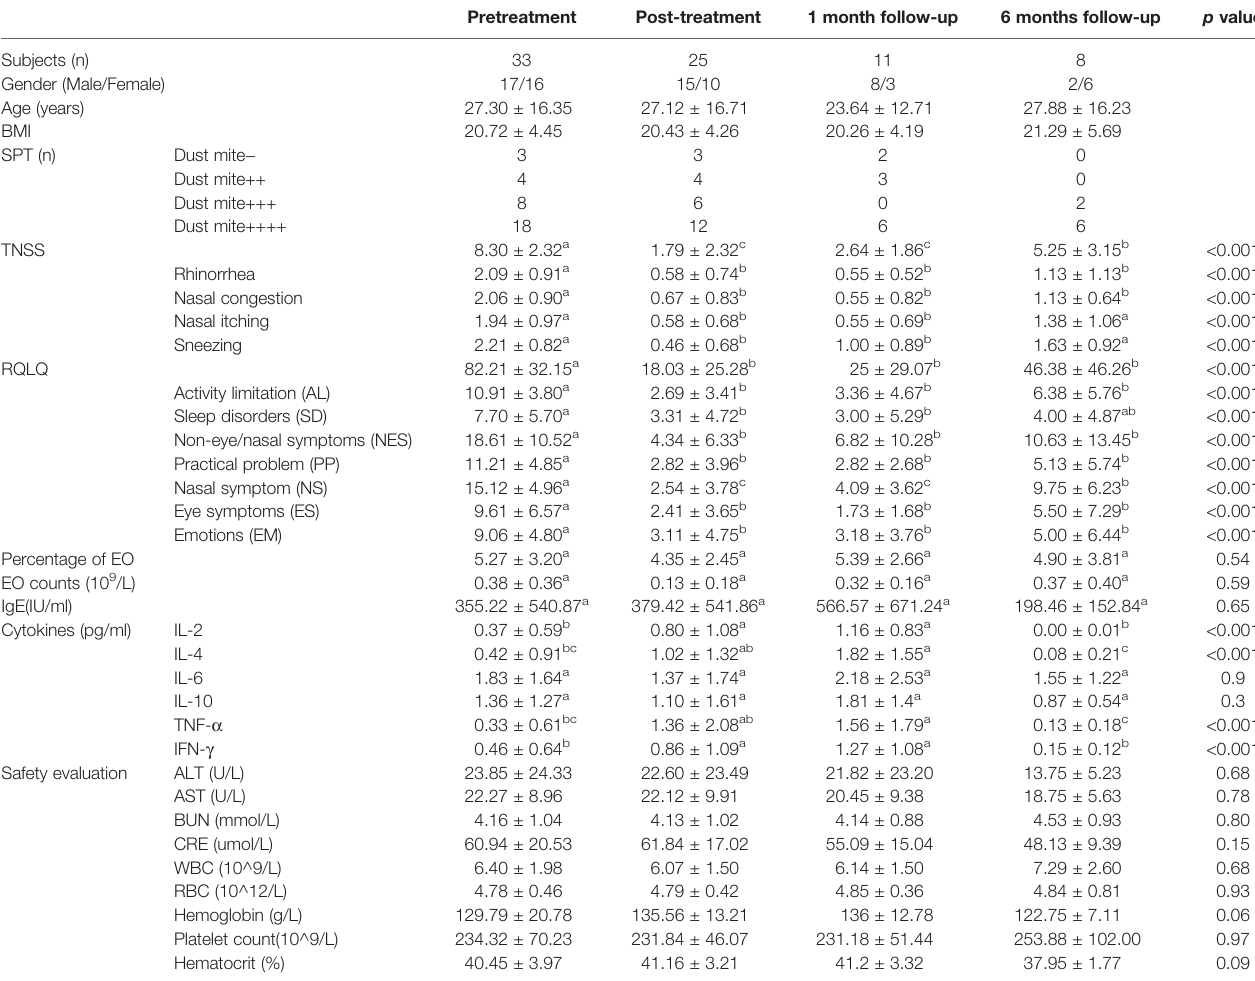
TABLE 1 | Clinical characteristics of participants at different time